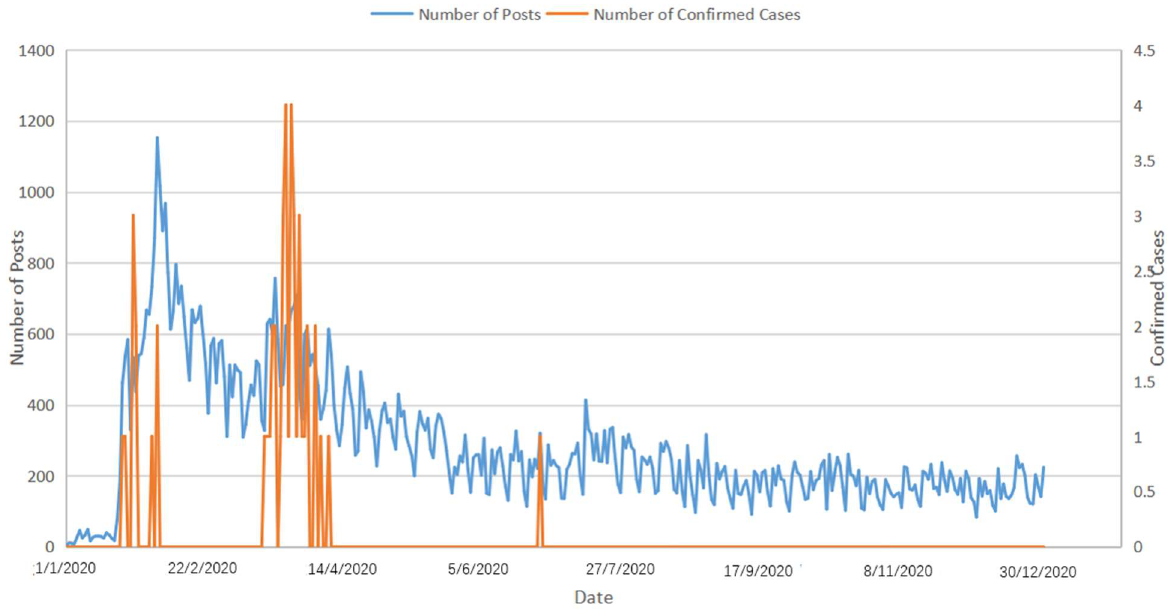
Figure 1. Number of collected posts compared with infectious cases (1 January to 31 December